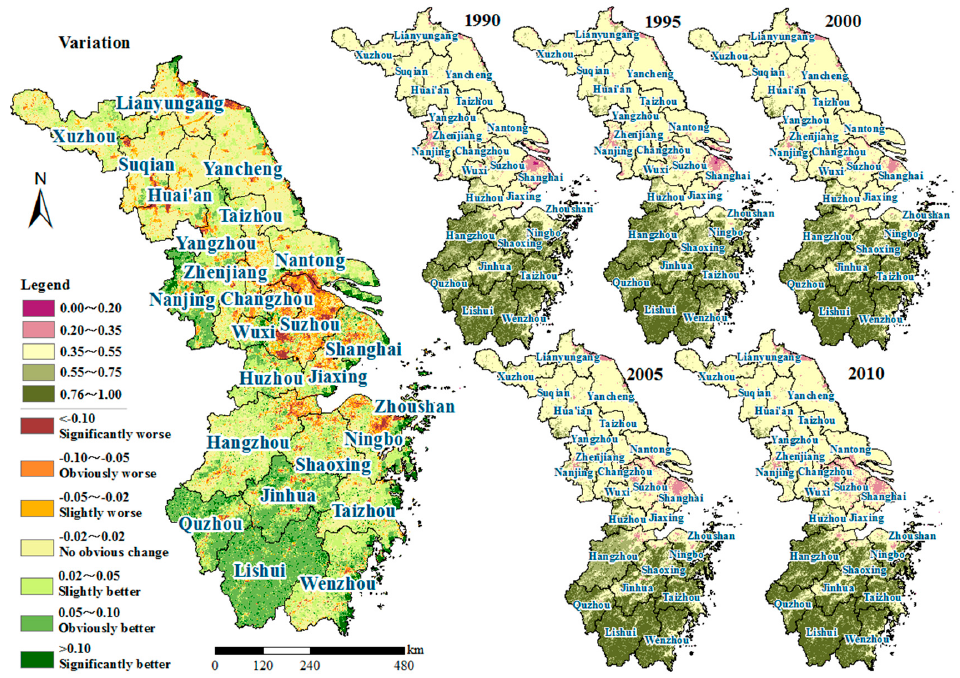
Figure 3. Spatial distribution of Eco_C and its variations in the YRD during 1990–2010.